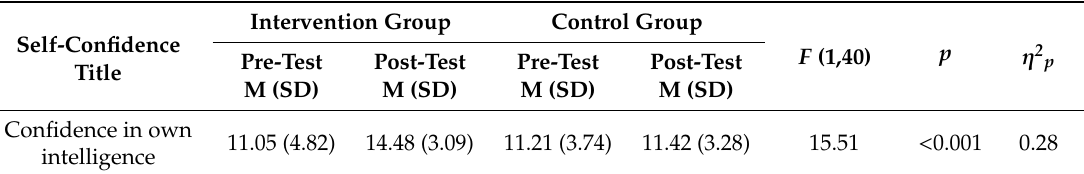
Table 7. Confidence in own intelligence (QC